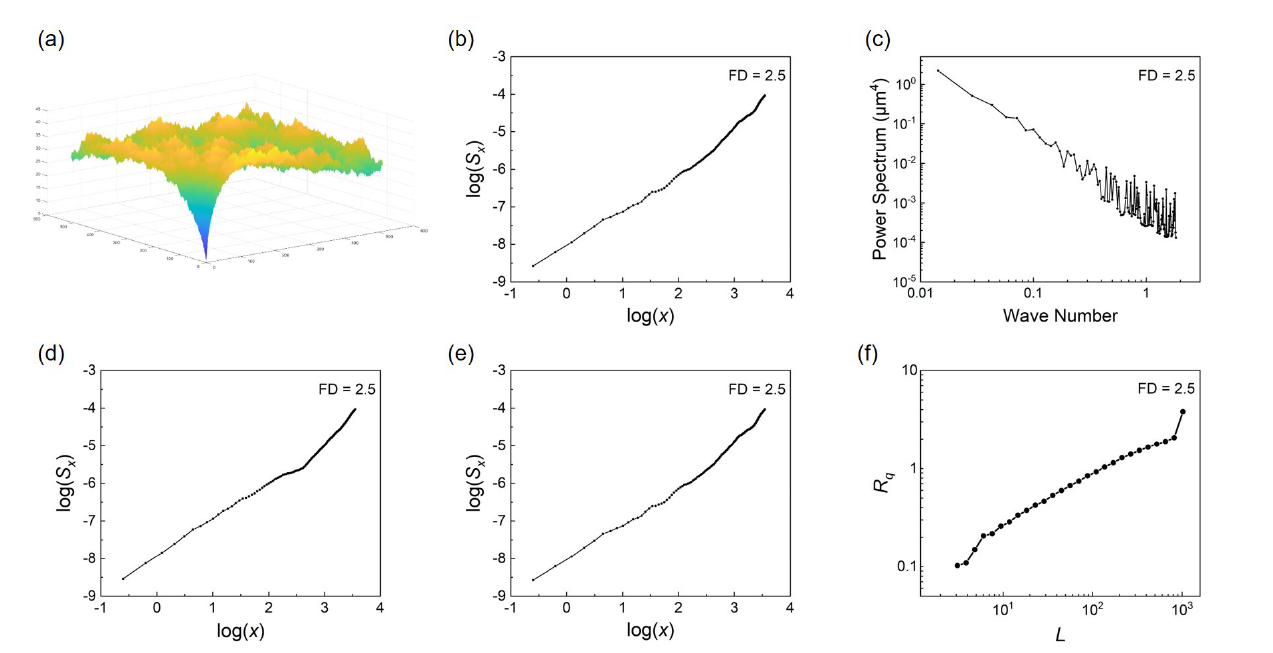
Figure 4. The typical FD evaluation procedures of artificial surfaces by W-M function shown in ( a ), ( b ) CC method, ( c ) PSD method, ( d ) the SF method, ( e ) the ACF method, ( f ) the RSE-p1